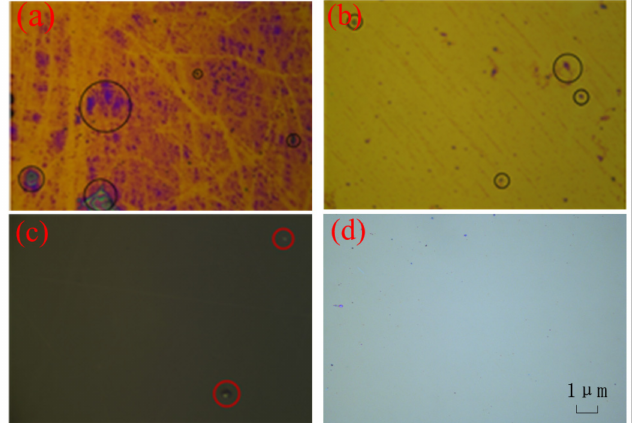
Figure 6. Glass surface at different positions under the microscope: ( a ) R = 0; ( b ) R = 4; ( c ) R = 8; ( d ) R = 12.